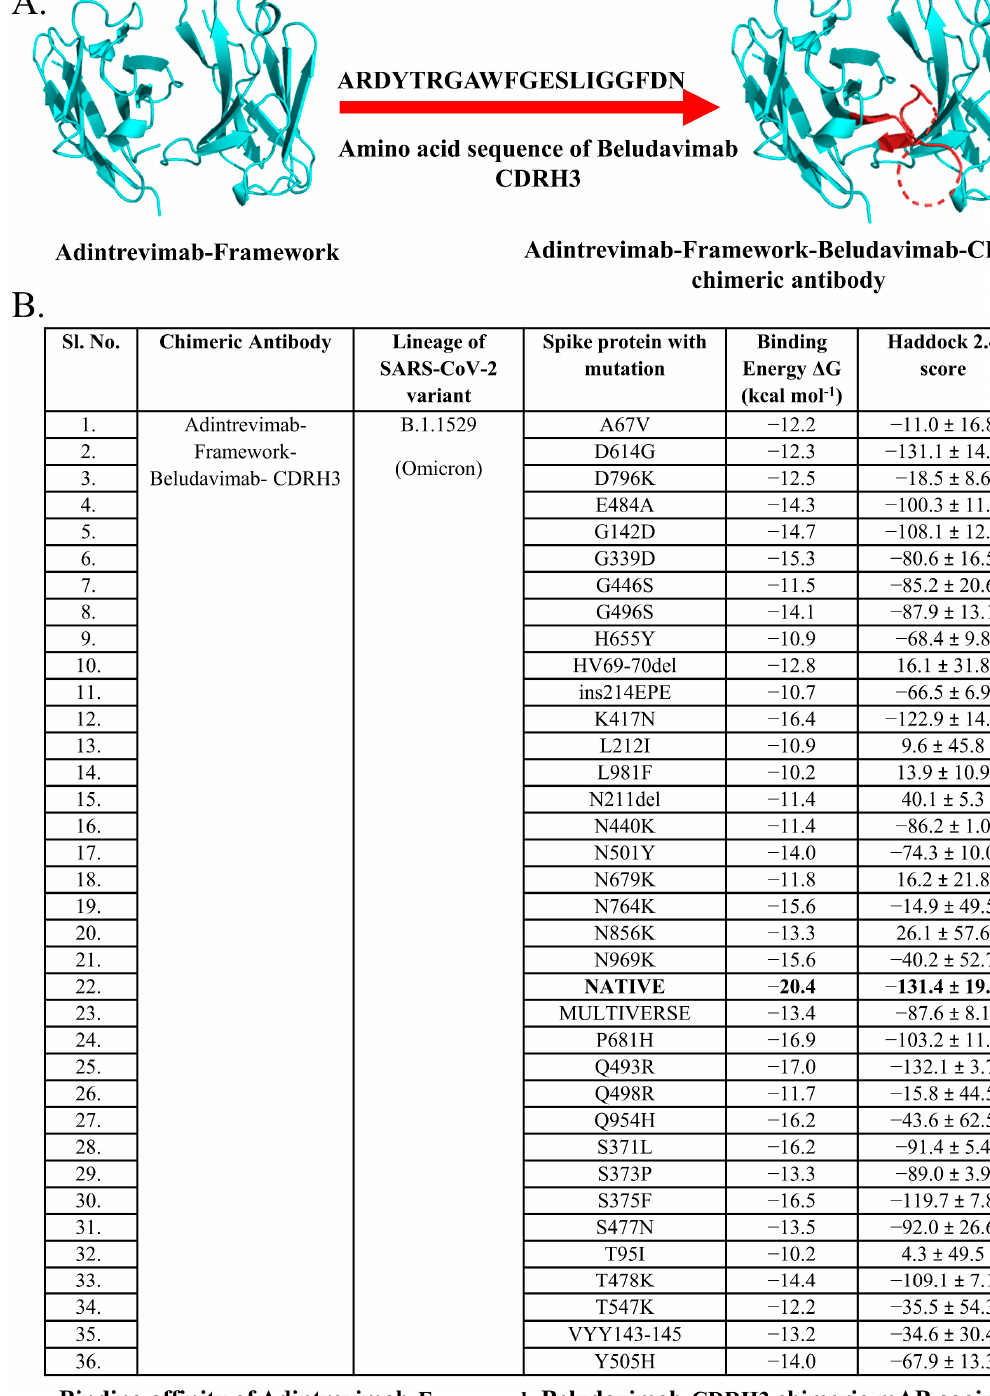
Figure 3. Predicted binding affinity of Adintrevimab-Framework-Beludavimab-CDRH3 chimeric mAb. ( A ) Structure of Adintrevimab-Framework-Beludavimab-CDRH3 chimeric mAb. ( B ) Predicted neutralizing efficacy of Adintrevimab-Framework-Beludavimab-CDRH3 chimeric mAb against omicron variant of SARS-CoV-2. Bold value is the best.